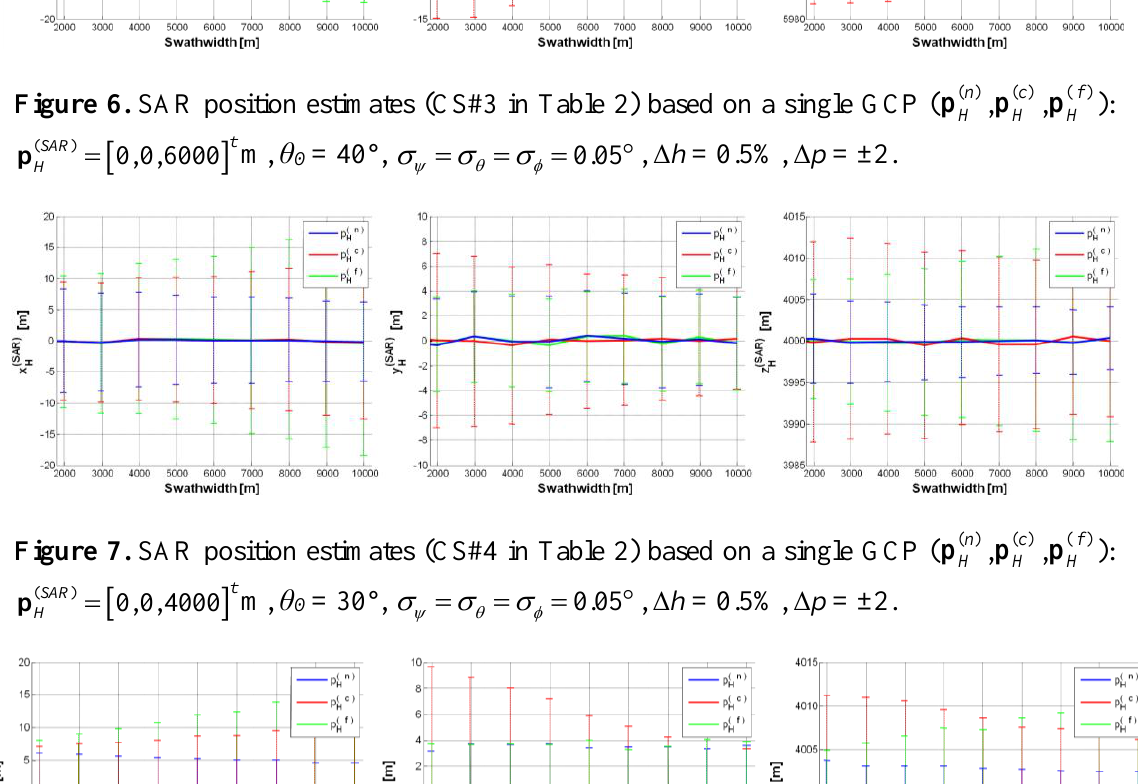
Figure 6. SAR position estimates (CS#3 in Table 2) based on a single GCP ( ( ) n